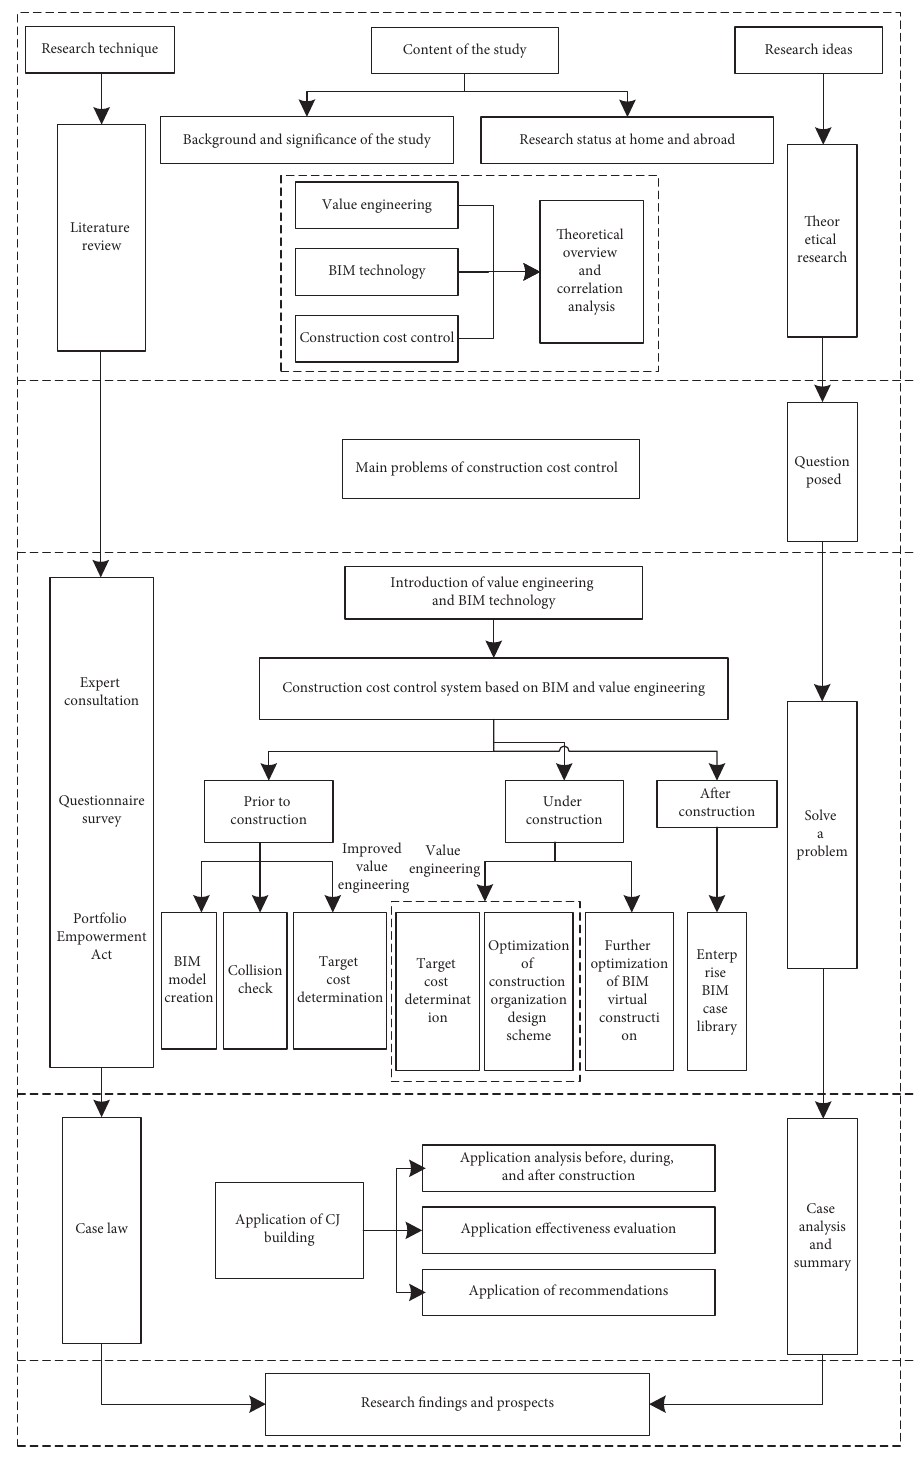
Figure 3: The research